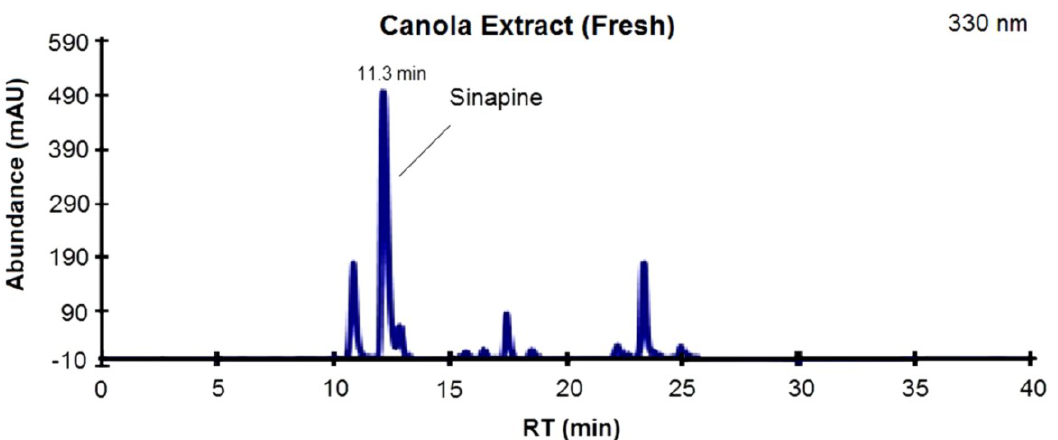
Figure 1. A representative high-performance liquid chromatography-diode array detector (HPLC-DAD) chromatogram (330 nm) of phenolic extracts from canola cotyledons showing the principal component sinapine (RT 11.3